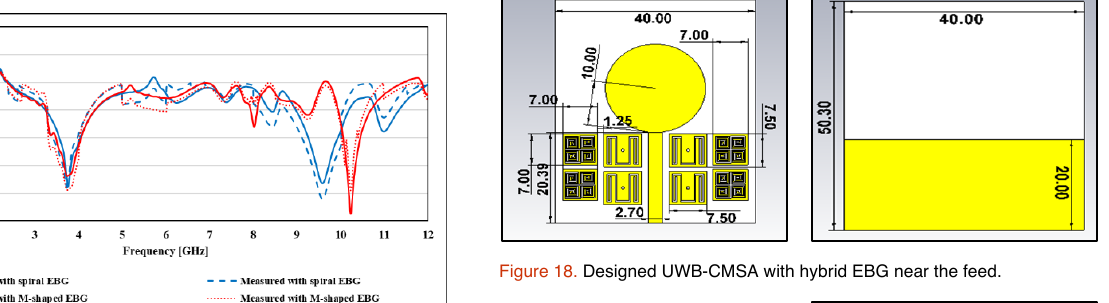
Figure 16. Designed UWB-CMSA with M-shaped EBG near the feed.